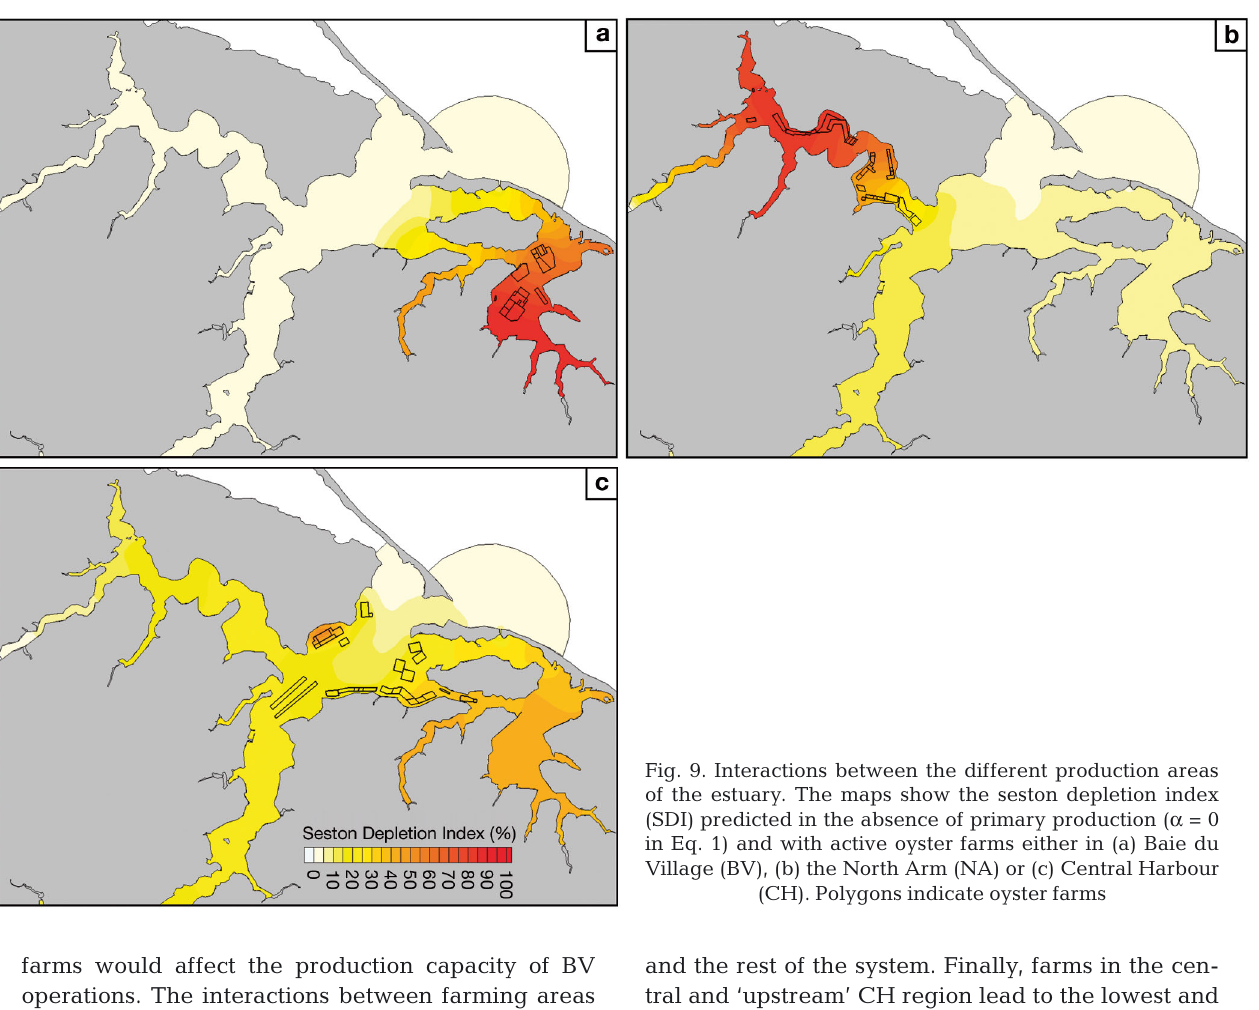
Fig. 9. Interactions between the different production areas of the estuary. The maps show the seston depletion index (SDI) predicted in the absence of primary production ( α = 0 in Eq. 1) and with active oyster farms either in (a) Baie du Village (BV), (b) the North Arm (NA) or (c) Central Harbour (CH). Polygons indicate oyster